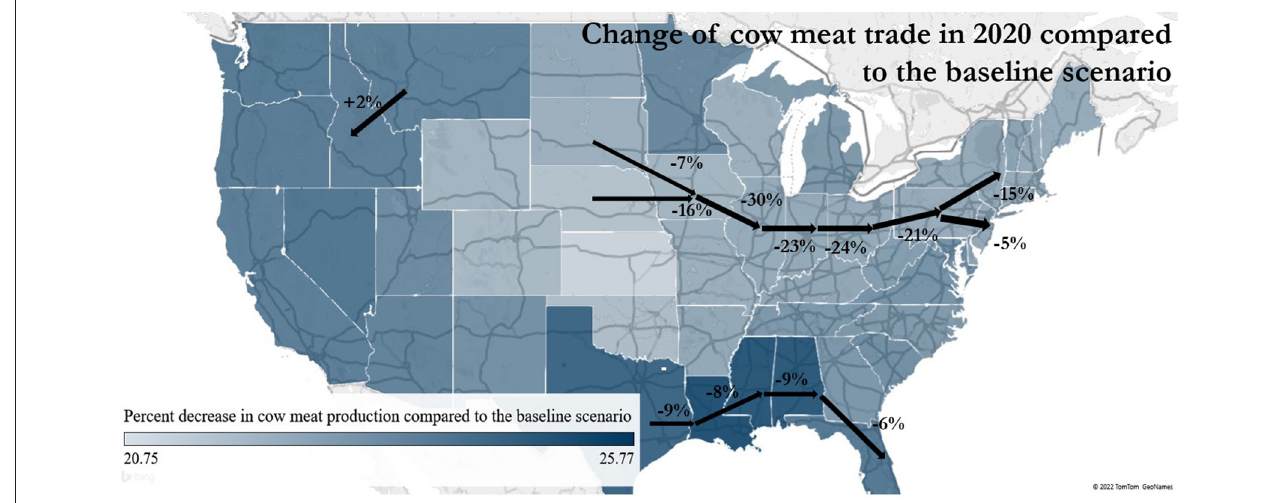
FIGURE 9 | Decrease in cow meat trade in 2020 compared to the baseline scenario, between selected states. The change in trade between states can range and need not be the same as the change in state-level production or consumption.